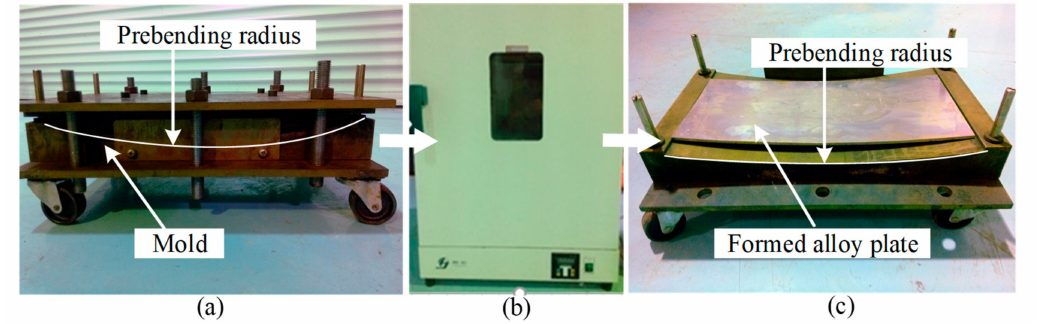
Figure 1. Creep age forming experiment: ( a ) prebending, ( b ) aging, and ( c ) unloading. Table 1. The parameters of the experiments. Group No. Temperature / K